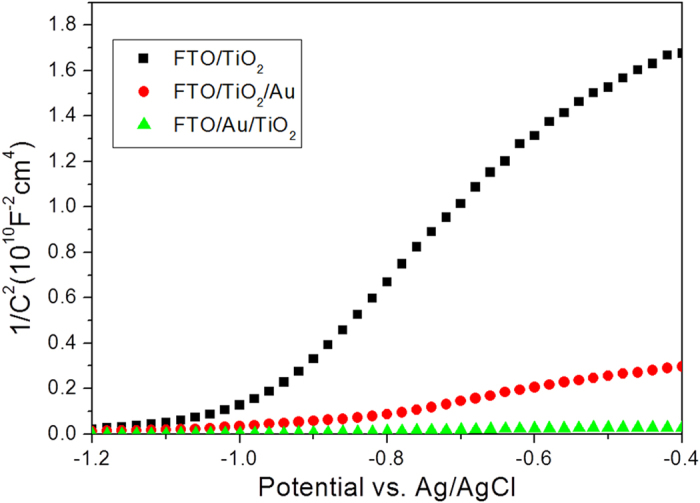
The MS curves of FTO/TiO2, FTO/TiO2/Au and FTO/Au/TiO2 photoelectrodes.